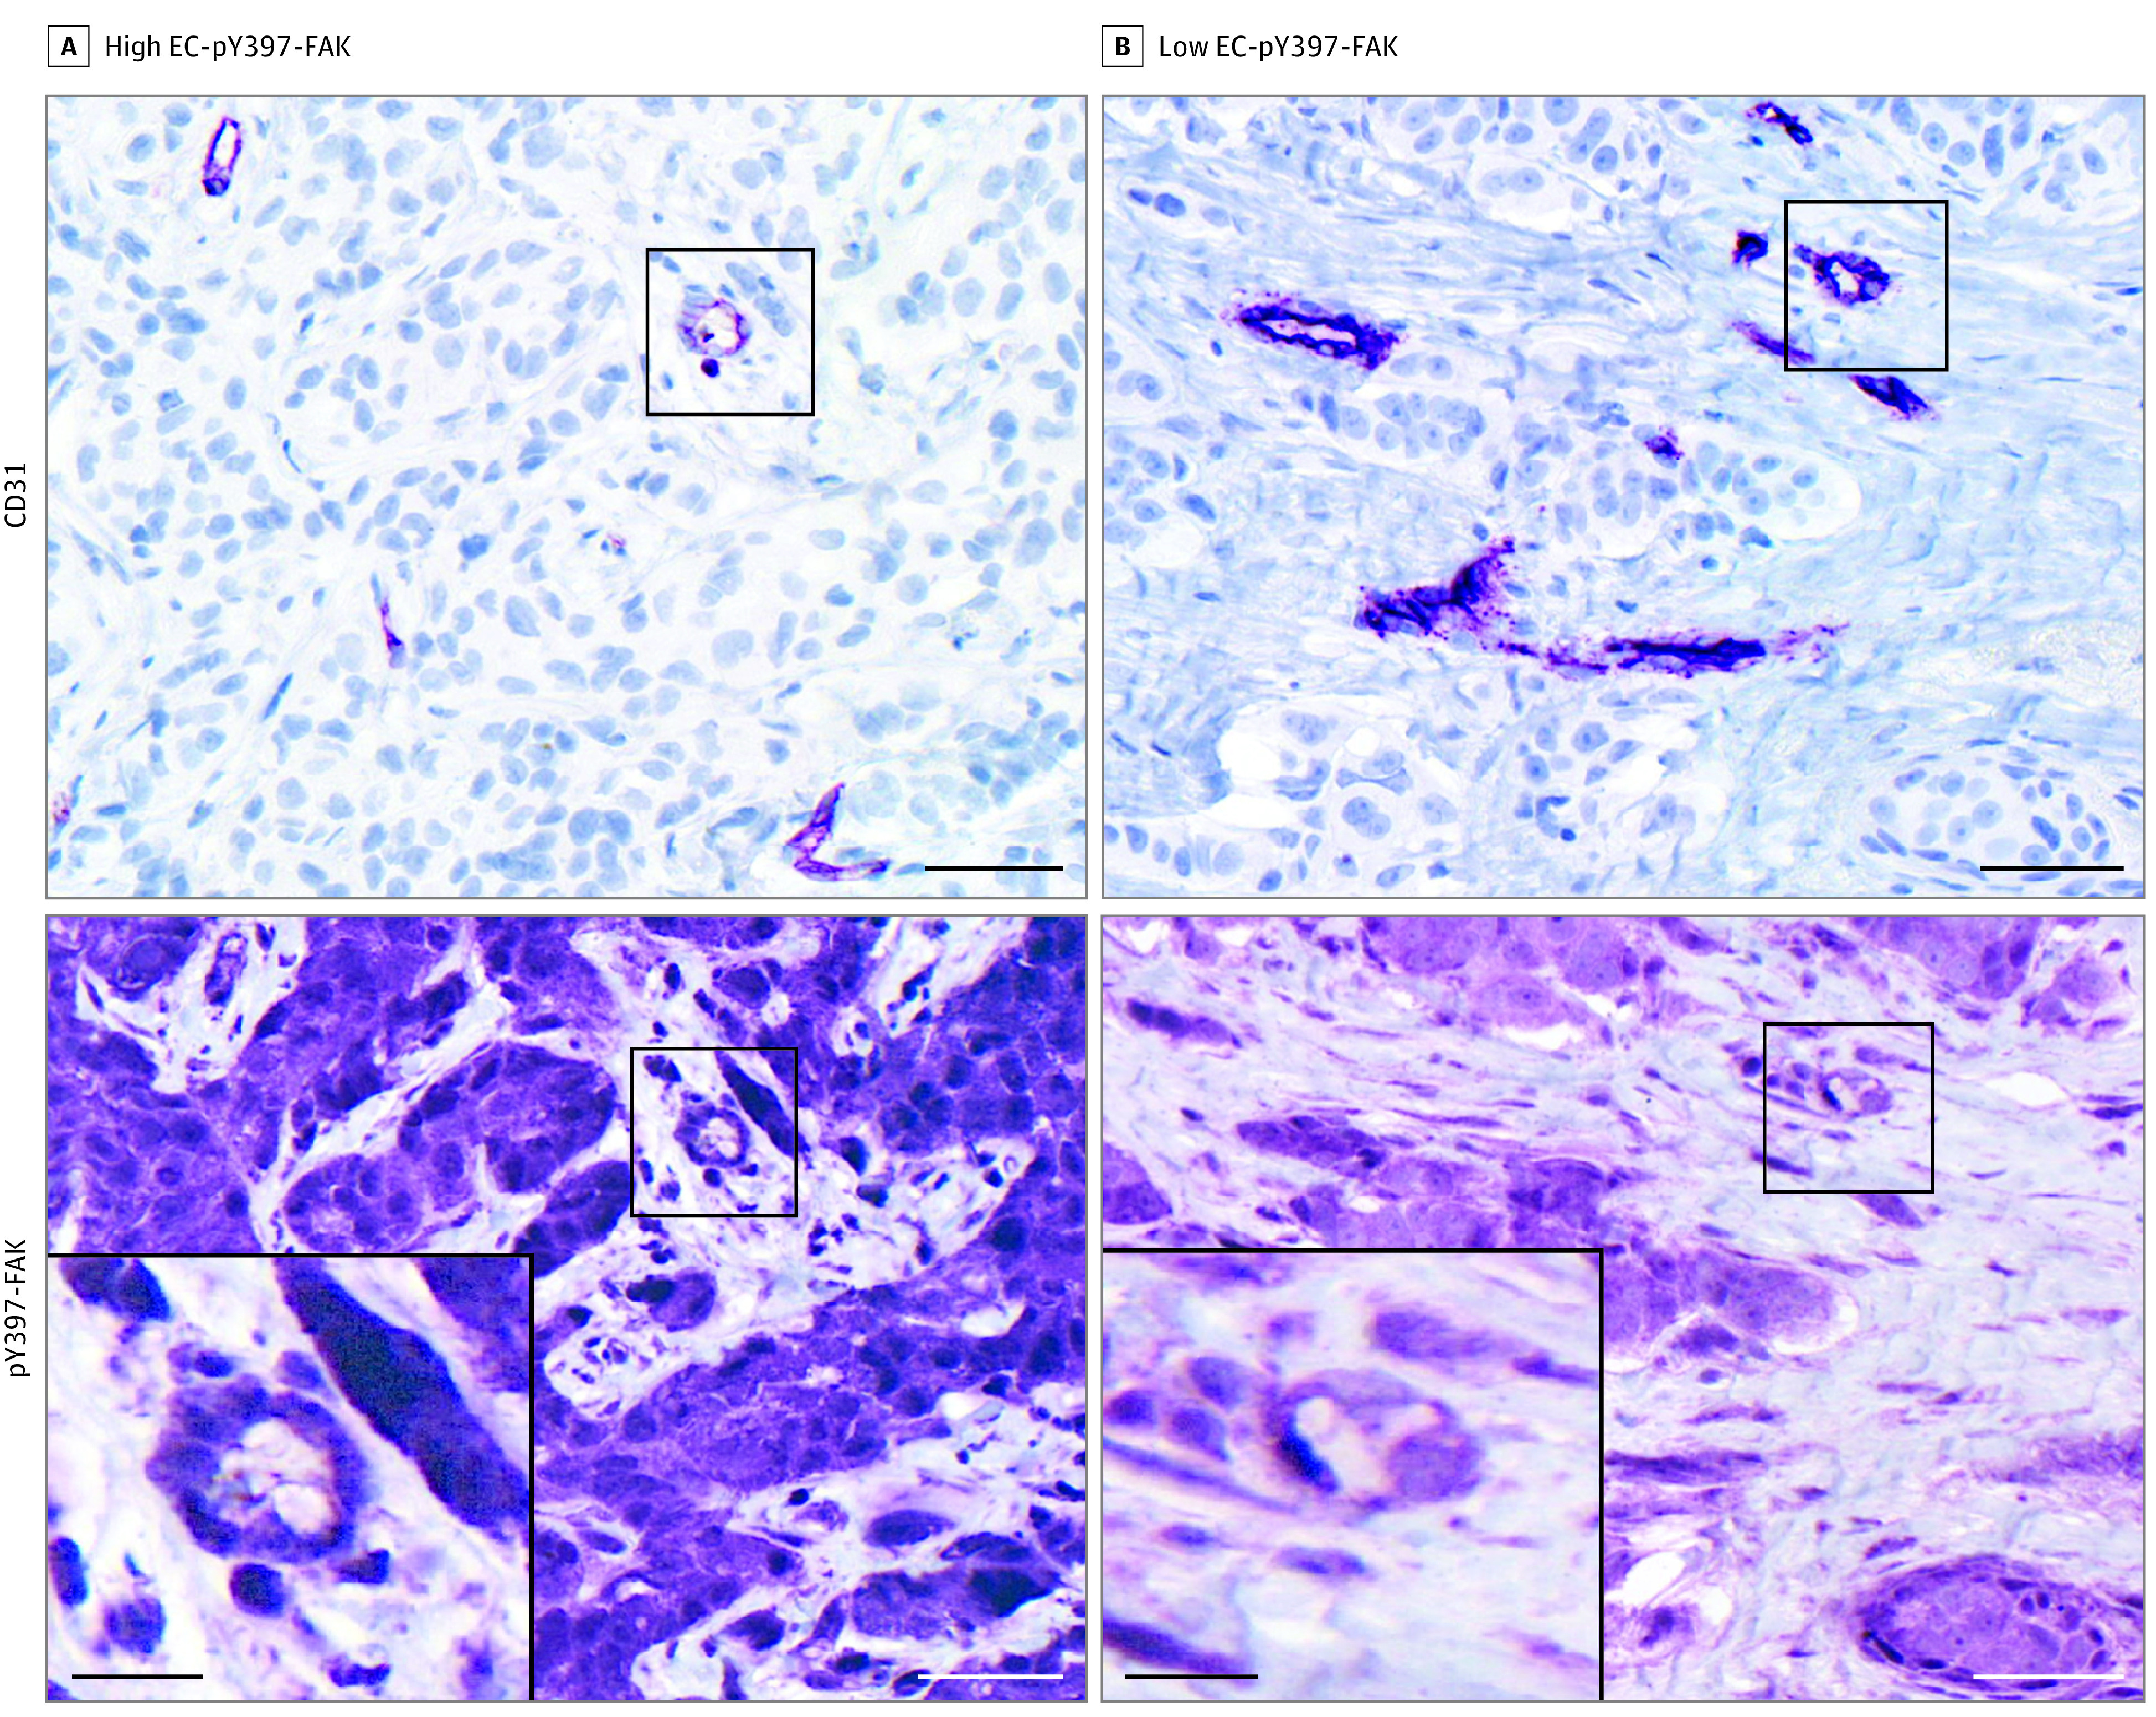
Immunohistochemical Analysis of High and Low Endothelial Cell Phosphorylated–Focal Adhesion Kinase (EC-pY397-FAK) Expression LevelsRepresentative images of high (A) and low (B) EC-pY397-FAK staining. Sections were immunostained for CD31, stripped, and reprobed for pY397-FAK. Expression levels were measured digitally in pY397-FAK/CD31 overlapping areas. Scale bar, 50 μm. Higher magnification inserts, scale bar, 15 μm.